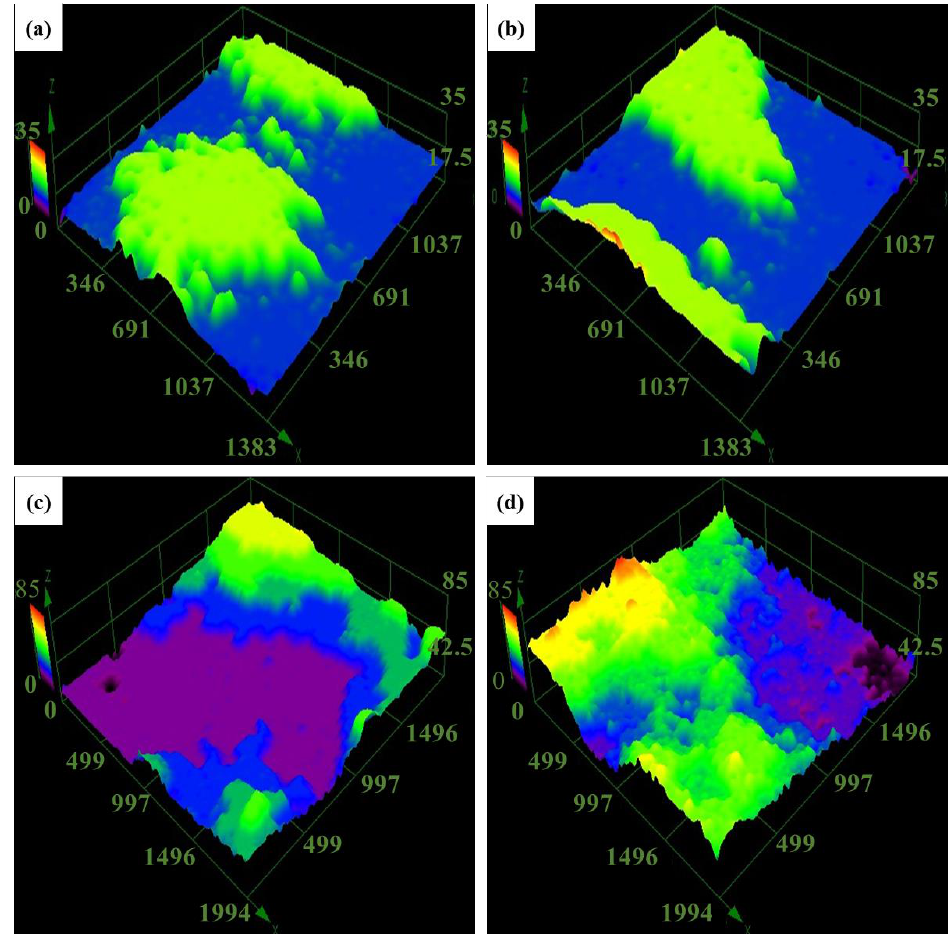
Figure 9. Altitude nephograms of the O-state and W-state alloys tensioned to a strain of 0.12 at 298 K and 77 K: ( a ) O-state, 298 K; ( b ) O-state, 77 K; ( c ) W-state, 298 K; ( d ) W-state, 77 K. Table 1. Surface roughness of the O-state and W-state alloys tensioned to a strain of 0.12. Deformation Temperature/K